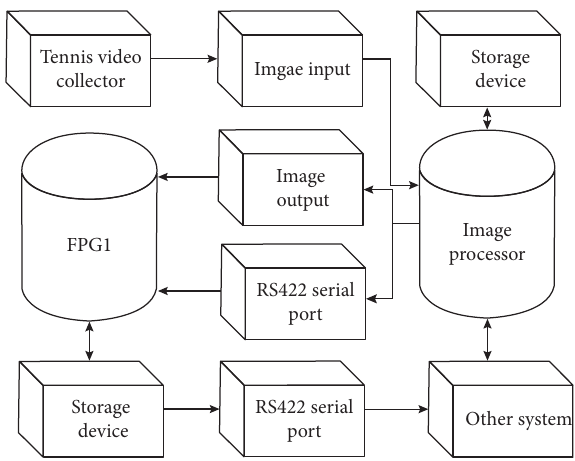
Figure 3: Motion monitoring image system